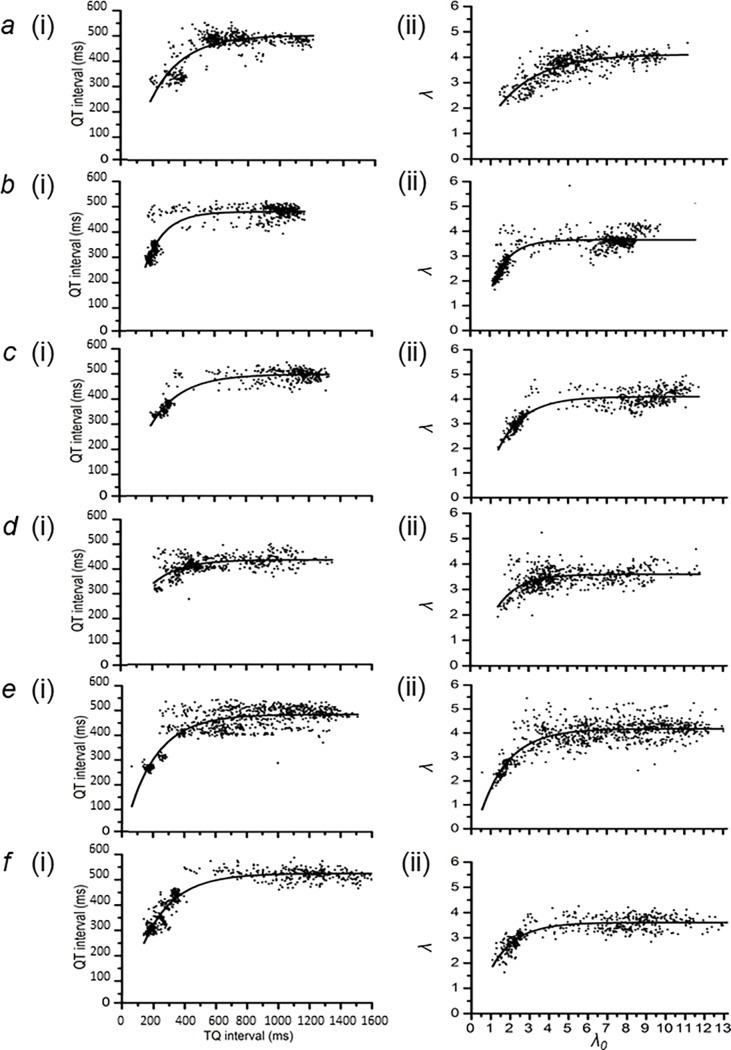
Comparison of electrocardiographic parameters at baseline and critical HRs.(a)–(f) Plots of QT vs. TQ interval ((i)) and lambda vs. lambda0 ((ii)), representing of action potential duration and wavelength restitution respectively, from the same 6 thoroughbred horses as in Fig 6. (a) Eq34 (a 2 year old male thoroughbred), (b) Eq39 (a 3 year old female thoroughbred), (c) Eq44 (a 4 year old female thoroughbred), (d) Eq52 (a 2 year old male thoroughbred), (e) Eq56 (a 2 year old male thoroughbred) and (f) Eq67 (a 3 year old male thoroughbred).